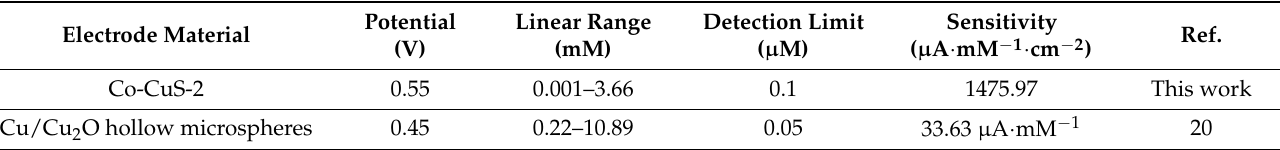
Table 2. Comparison of the Co-CuS-2 electrode with some reported sensors for glucose detection.